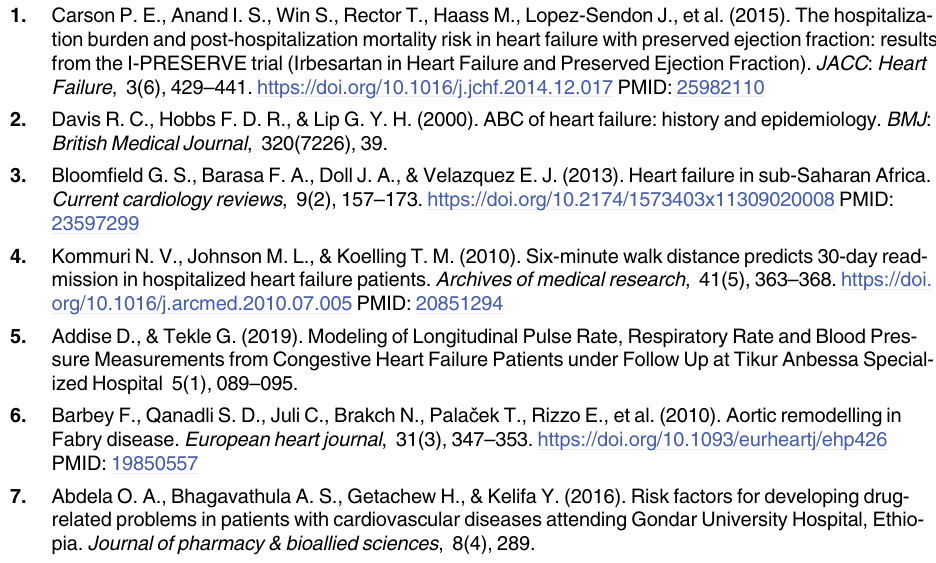
S2 Fig. Normal probability plot of standardized residuals from longitudinal sub model. S3 Fig. Schoenfeld residual plots of covariates: Tuberculosis and chronic